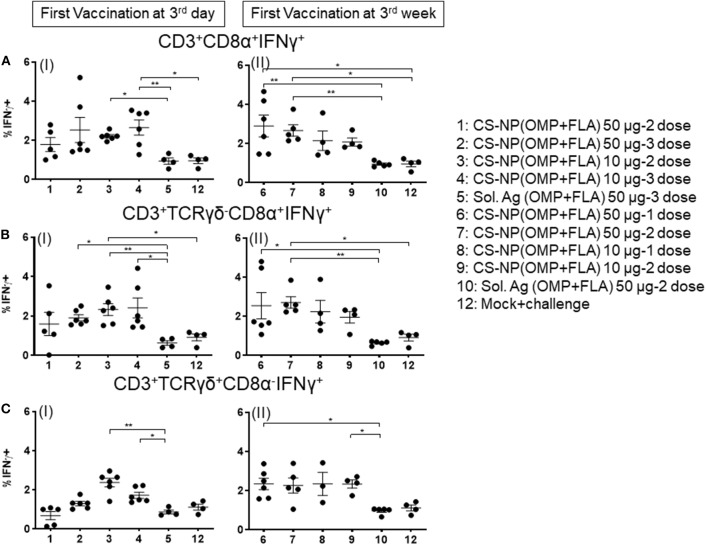
Salmonella antigen specific proliferated T lymphocyte subsets in the splenocyte of vaccinated and SE challenge birds. Splenocytes isolated on the day of necropsy were restimulated with vaccine antigens (OMP+FLA). The frequency of activated IFNγ+ secreting lymphocytes were determined by flow cytometry. Average frequency of lymphocytes: (A) CD3+CD8α+IFNγ+ (I and II); (B) CD3+TCRγδ−CD8α+IFNγ+ (I and II); and (C) CD3+TCRγδ+CD8α−IFNγ+ (I and II) from all the experimental groups were quantified. Data were presented as average percentage of indicated lymphocyte subset ± SEM. Significant differences were calculated between vaccinated and Sol. Ag (OMP+FLA) or mock challenge group by Kruskal–Wallis test followed by Dunn's multiple comparison test. *P < 0.05, **P < 0.01.